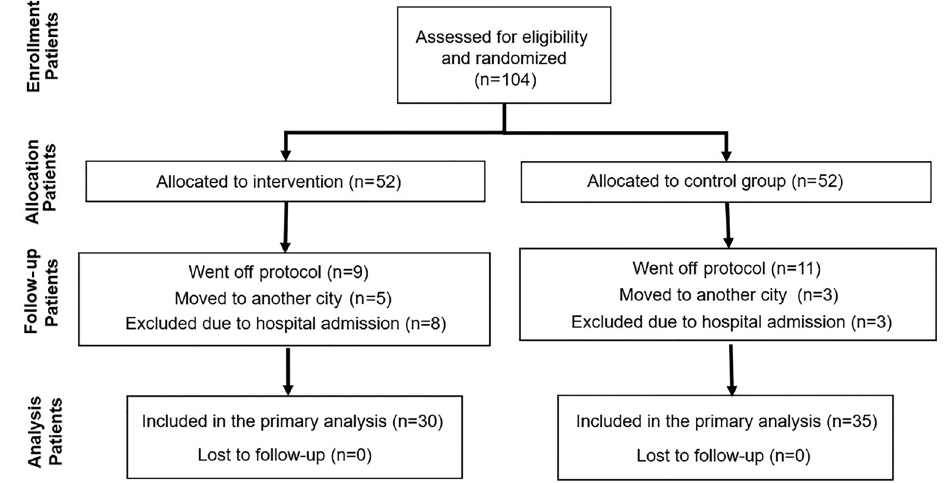
Figure 1. Flow diagram of participants in the study.